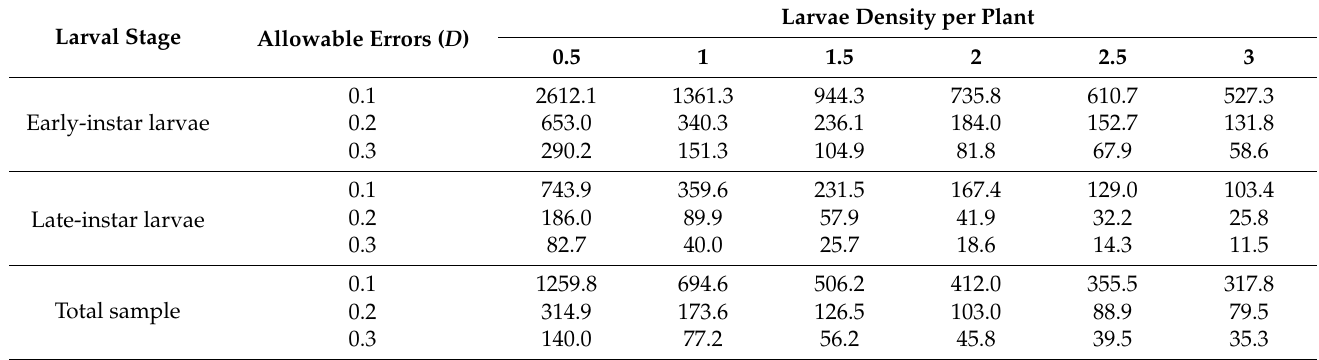
Table 6. Theoretical sampling numbers of S. frugiperda larvae in maize fields at different densities in 2021.